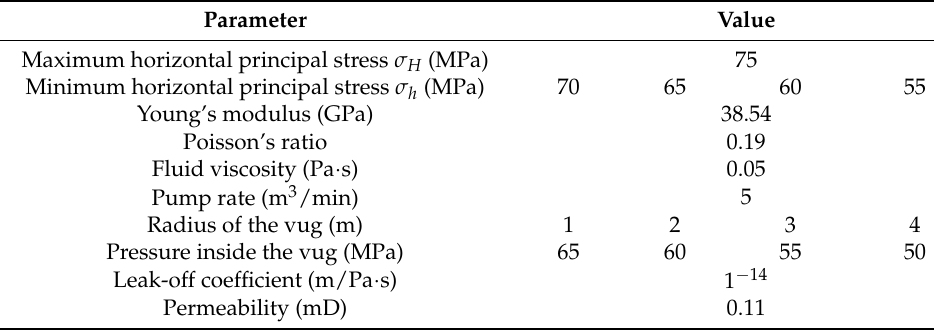
Figure 12. Numerical model schematic. Table 2. Basic parameters of the simulated